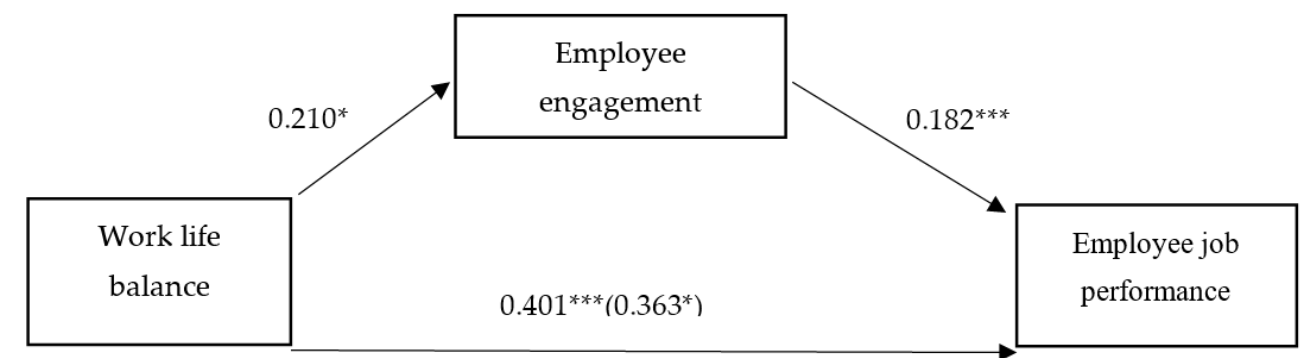
Figure 3. Mediation model ( n = 220). Indirect effects of work-life balance on employee job performance through employee engagement. Standardized effects estimates are presented. The effects on the direct path from work-life balance to employee job performance depict the direct effect and the (total effect). Notes: * p = 0.004, *** p < 0.001.